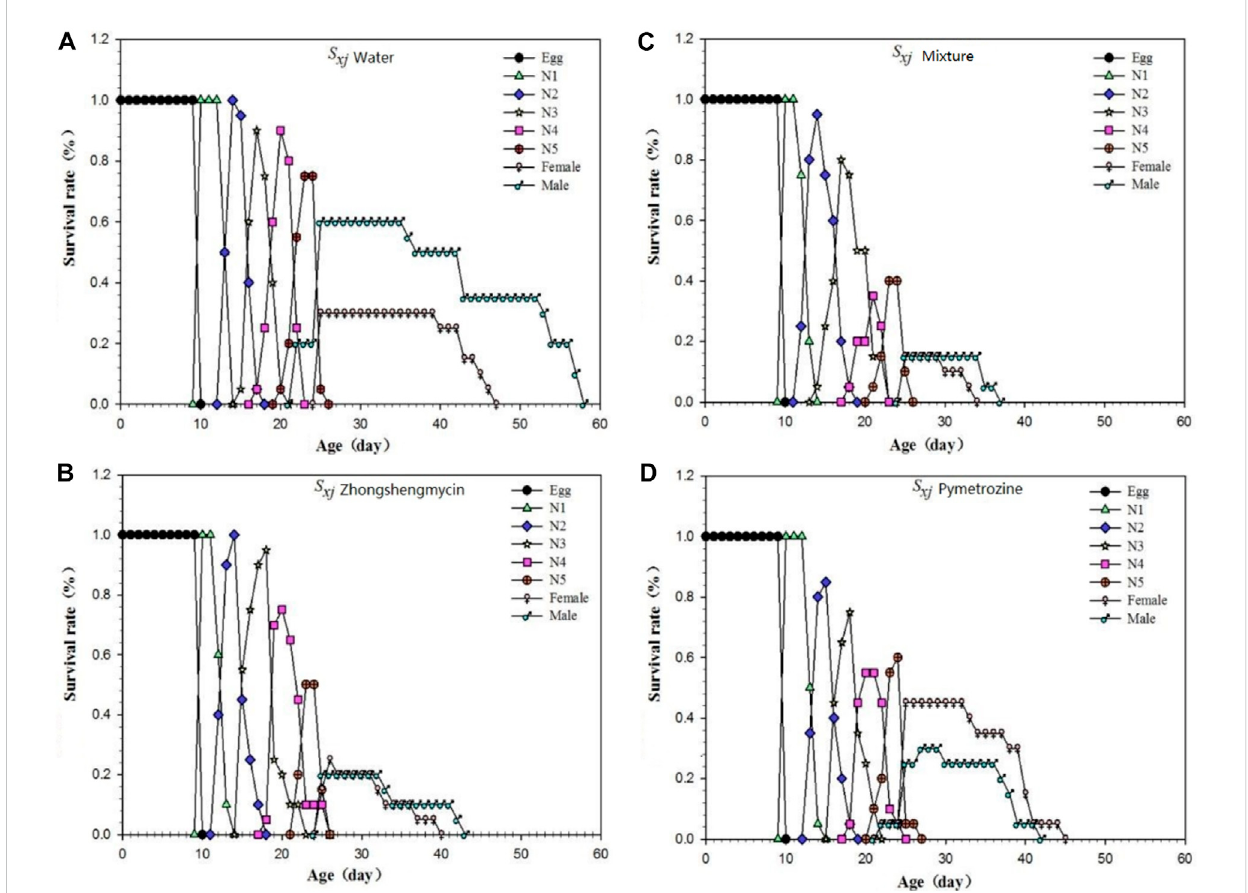
FIGURE 1 Age-stage-speci fi c survival rate of N. lugens (A) Age-stage-speci fi c survival rate ( S xj ) of N. lugens in the water treatment; (B) age-stage-speci fi c survival rate ( S xj ) of N. lugens in the zhongshengmycin treatment; (C) age-stage-speci fi c survival rate ( S xj ) of N. lugens in the mixture treatment; (D) age- stage-speci fi c survival rate ( S xj ) of N. lugens in the pymetrozine